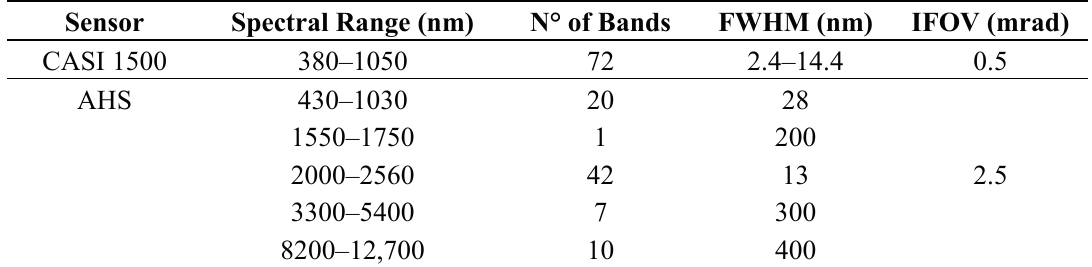
Table 1. Sensor characteristics and spectral region covered; FWHM is the full width at half maximum; IFOV is the instantaneous field of view.